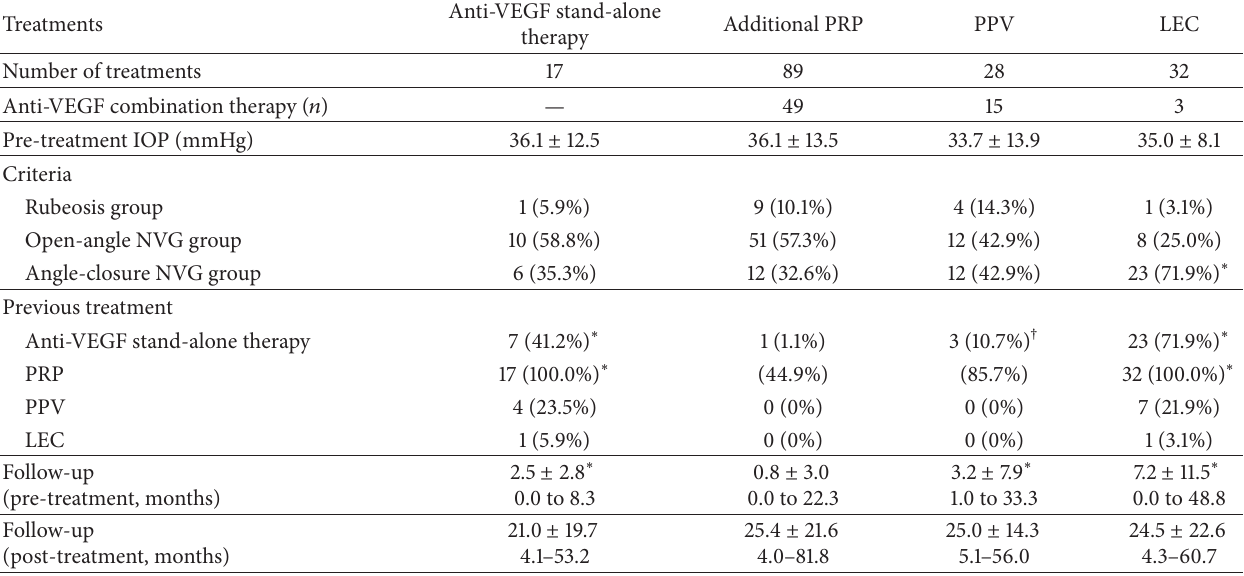
Table 2: NVG patient backgrounds according to treatment received. The majority of patients in the LEC group had stage 3 NVG and had previously received other treatments, such as adequate PRP, stand-alone anti-VEGF therapy, and PPV. Approximately half (41.2%) of patients that received frequent stand-alone anti-VEGF treatment had previously received repeated anti-VEGF injections.